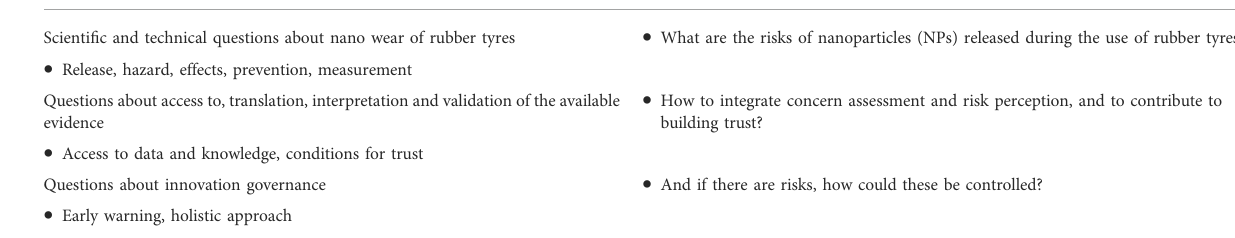
TABLE 2 Summarized questions as formulated by stakeholders in the pre-assessment